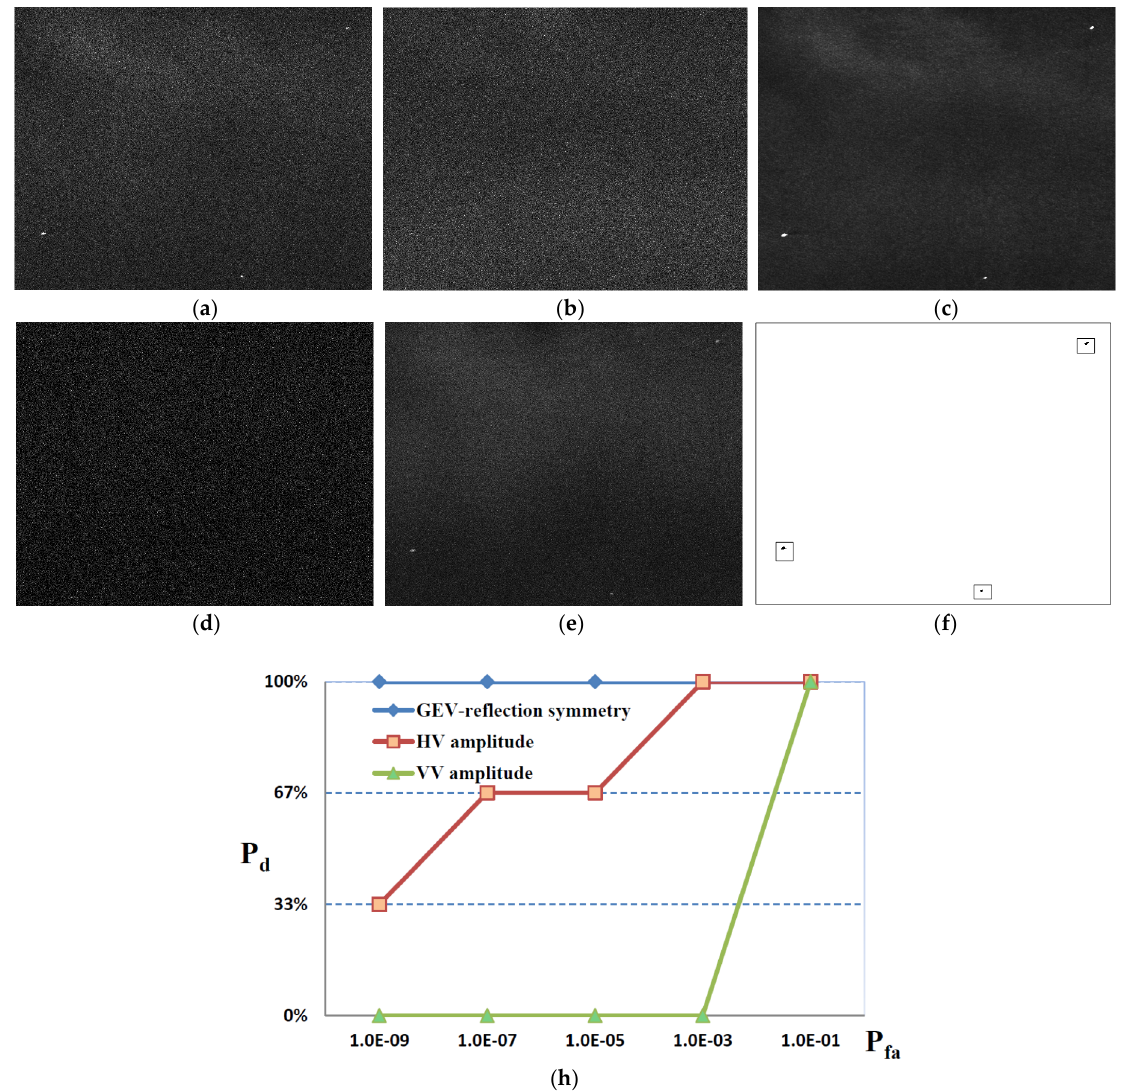
Figure 9. ( a ) VH amplitude; ( b ) VV amplitude; ( c ) reflection symmetry metric; ( d ) polarimetric entropy; ( e ) polarimetric scattering angle; ( f ) detection result; ( h ) detection results comparison with ROC